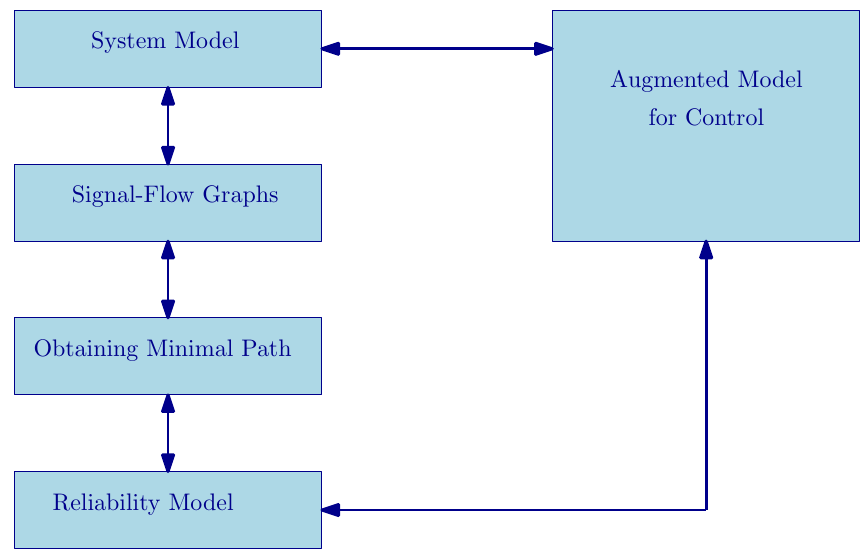
Figure 1. Digram of the new proposed control model